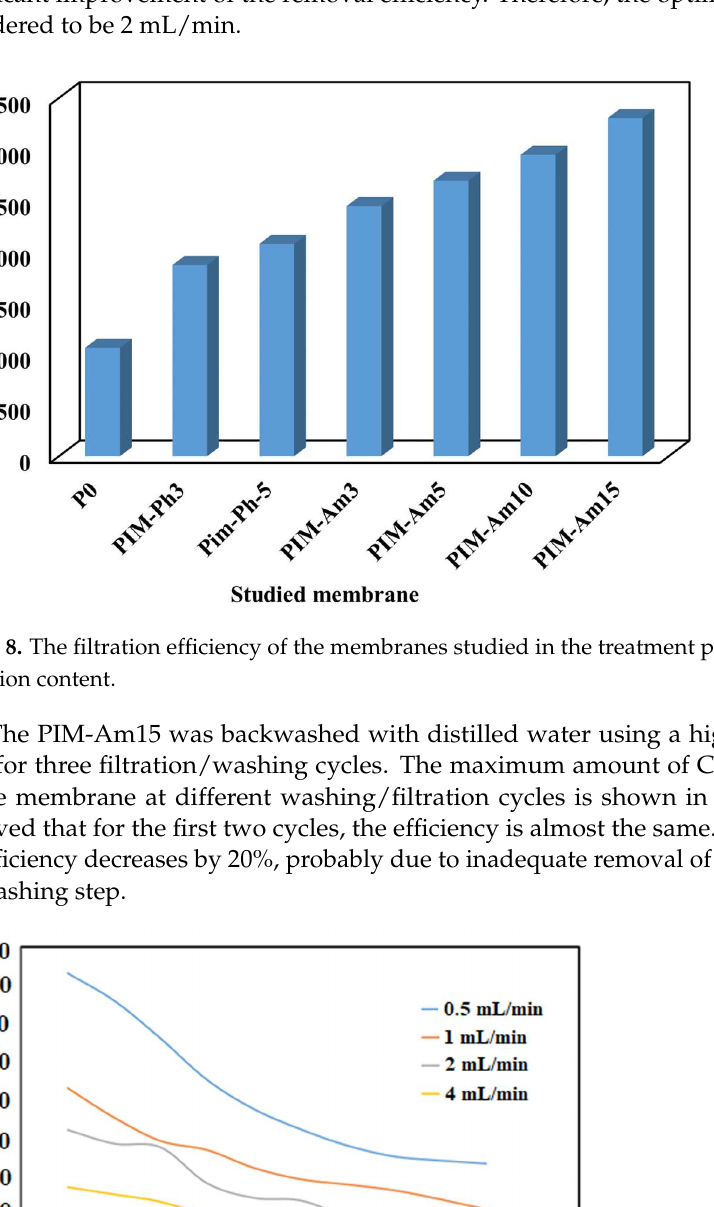
Figure 8. The filtration efficiency of the membranes studied in the treatment process of water with Cd(II) ion content.